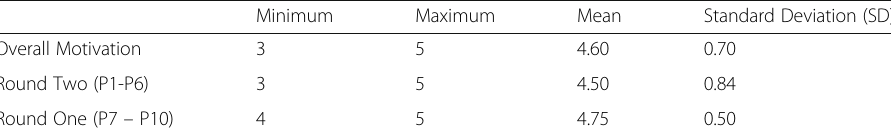
Table 1 Students ’ Learning Motivation for the Chinese